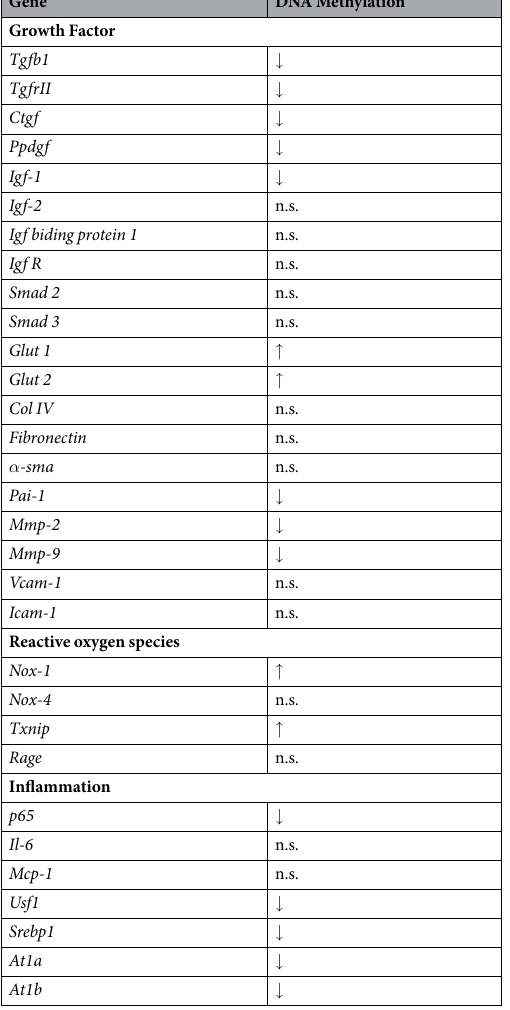
↓ Table 1. A list of the change of DNA methylation status of fibrosis related genes of db/db